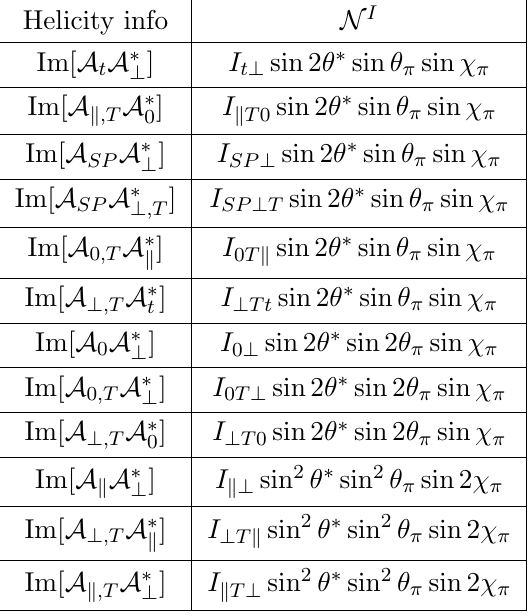
Table 7 . Contributions to the N I kinematic parameters q 2 and E (cid:25) , and are listed in eq. (B.4).